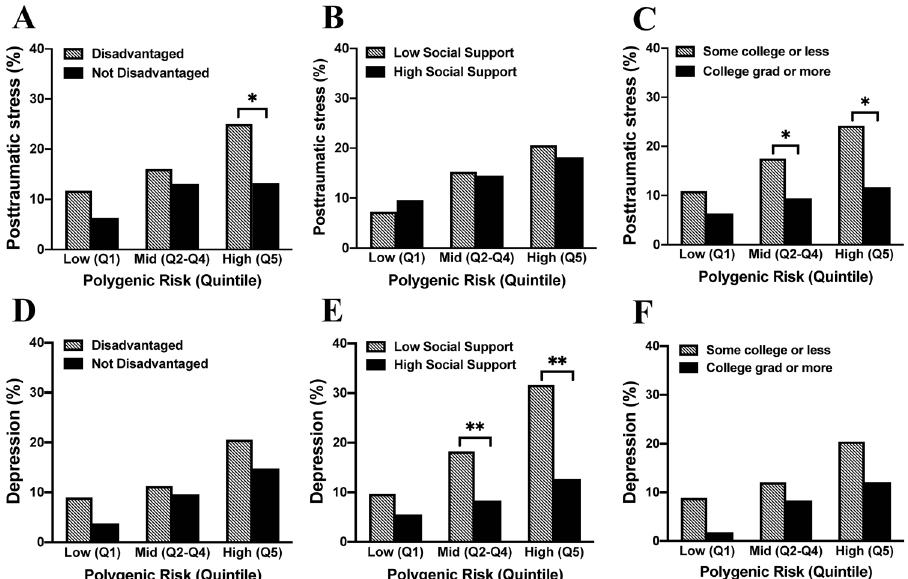
Fig. 3 Prevalence of posttraumatic stress (PTS) and depressive symptoms (DS) 6 months following motor vehicle collision (MVC) trauma based on PTSD GWAS polygenic risk scores and the effect that three social factors have on this genetic vulnerability to PTS and DS. Prevalence of PTS ( A – C ) and DS ( D – F ) were graphed for each polygenic risk group (de fi ned by quintiles as presented in Supplementary Fig. S4, with the second, third, and fourth quintiles grouped in the “ Mid ” risk category). A , D In fl uence of living in a disadvantaged neighborhood (striped bars) vs. a non-disadvantaged neighborhood (black bars) on genetic risk for PTS and DS. B , E In fl uence of social support on genetic risk for PTS and DS (striped bars represent low social support and black bars represent high social support). C , F In fl uence of education level on genetic risk for PTS and DS (striped bars represent some college or less and black bars represent college education or higher). Signi fi cance of equality of proportions models within each polygenic risk category are indicated above relevant bars; * p < 0.05, ** p <